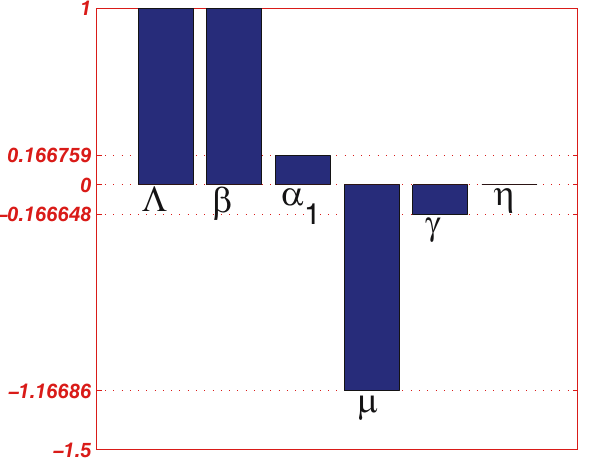
Figure 3: Sensitivity indices of R 0 with respect to model